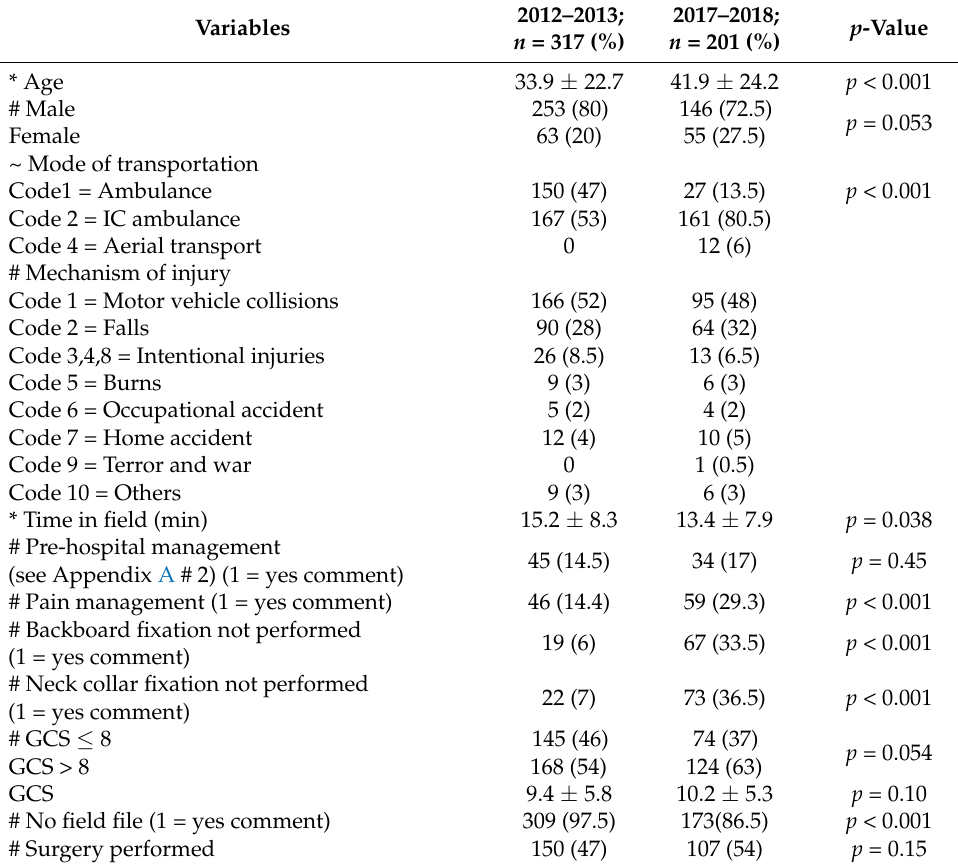
Table 2. Primary hospital team feedback.